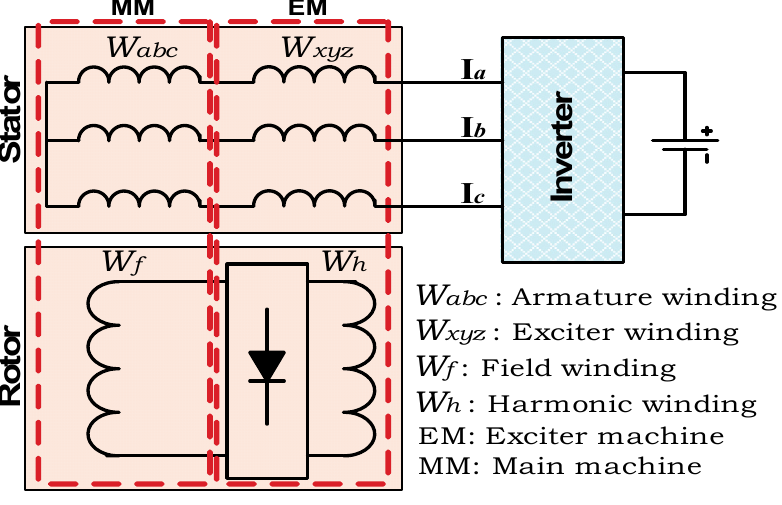
Figure 1. Schematic diagram of the proposed brushless WRSM.